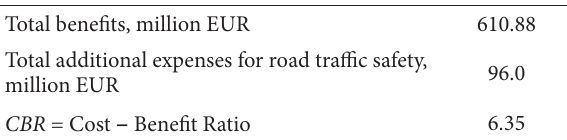
Table 3. Effectiveness of implementation of the Road Traffic Safety Programme 2007–2013